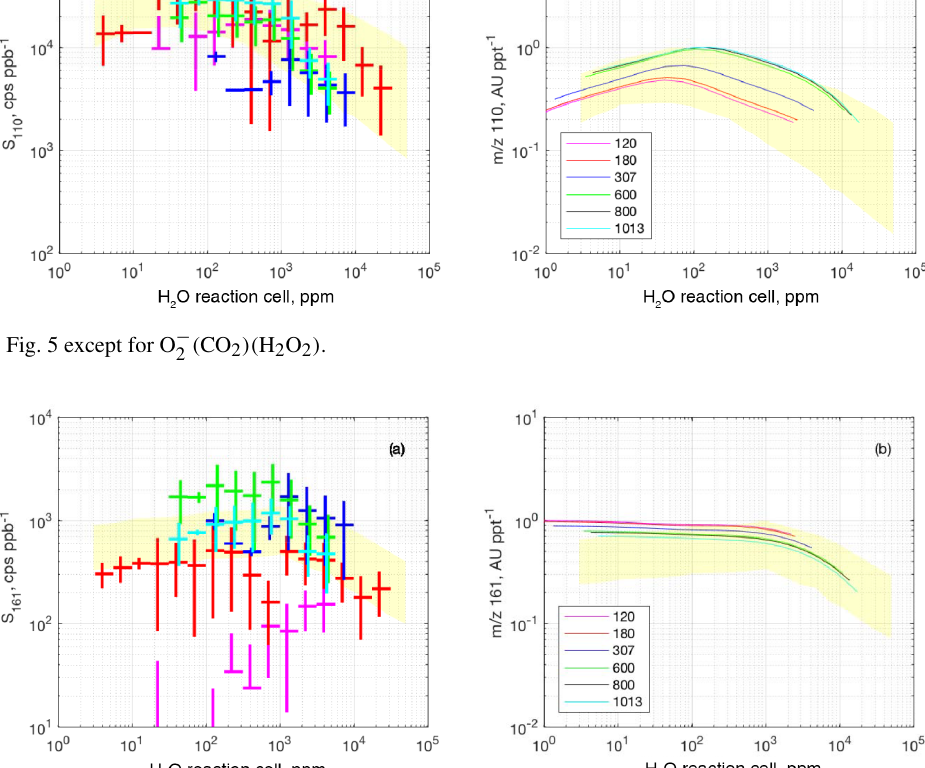
Figure 8. Same as Fig. 5 except for I − ( H 2 O 2 ) . Magenta crosses in panel (a) correspond to DC3 post mission calibrations without the addition of CH 3 I; there had been multiple refillings of the reagent CO 2 in the air bottle and the CH 3 I reagent gas concentration is presumed to be very